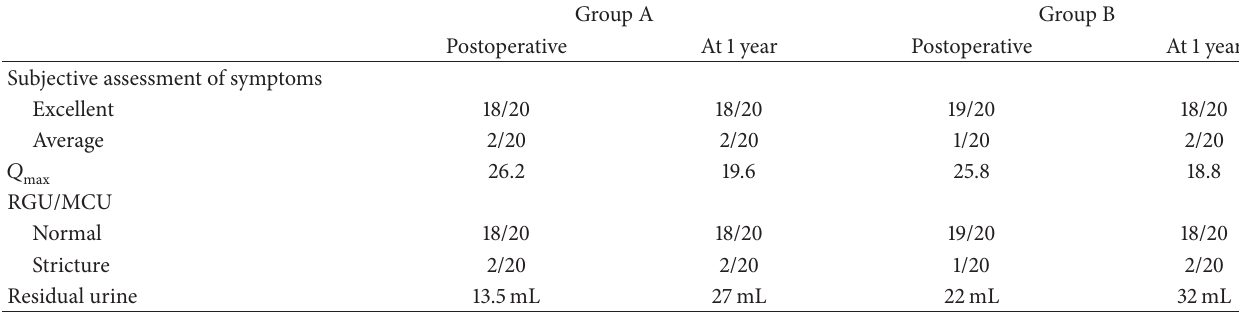
Table 2: Postoperative